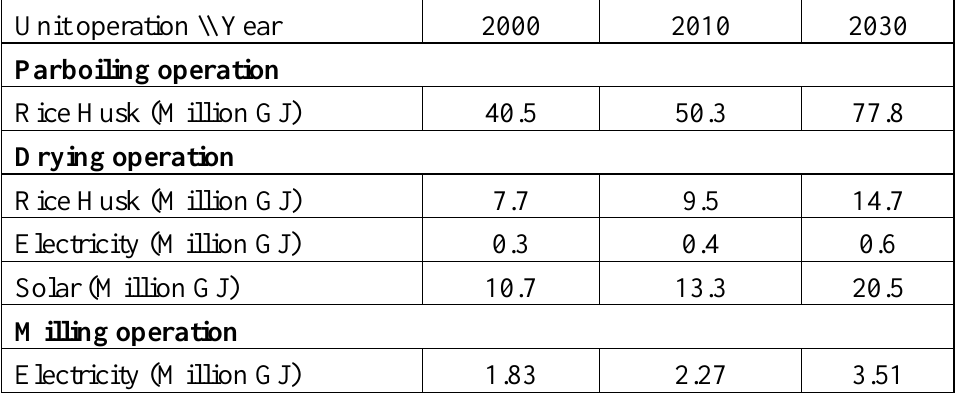
Table 3. Final energy demand for rice food grain process